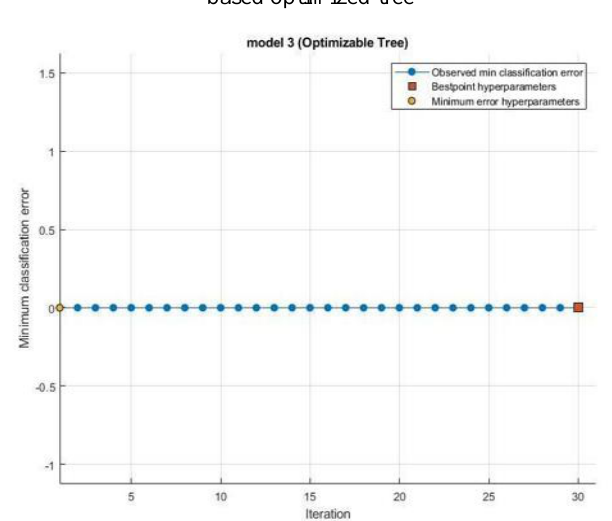
Fig. 17. OS scan minimum classification error of random search based optimized